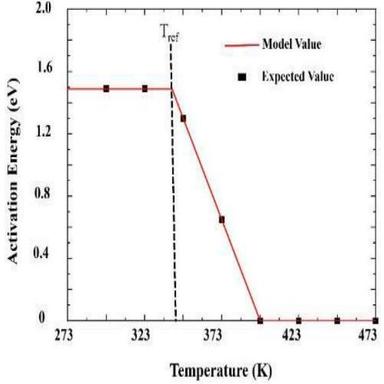
Expected and fitted values of the apparent activation energy of the underfill.